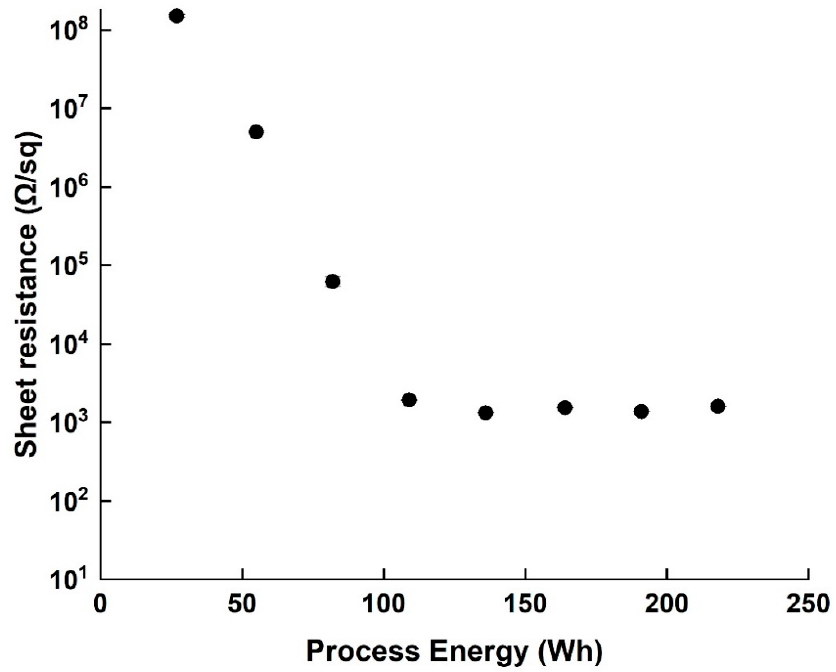
Figure 5. Sheet resistance values of PET film coated with dispersion after different process energy points (27–218 Wh).